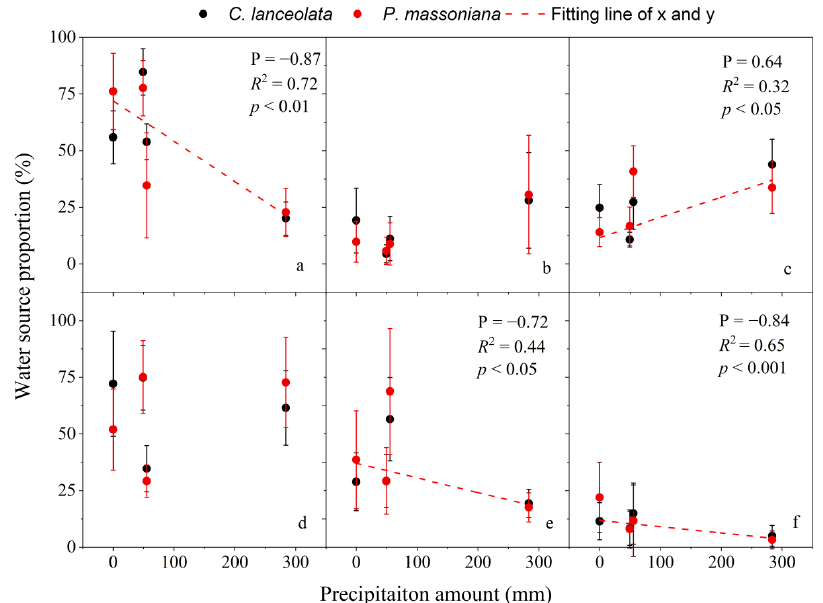
Figure 7. Relationships between water source proportions for each soil layers (mean ± S.D.) and the precipitation amount ten days before sampling. P is Pearson correlation, R 2 represents the fitting degree of the relationship between the water source proportion and the precipitation amount; p is the p -value of the fitting (( a – c ) plant water sources from the shallow, middle, and deep layers in the edaphic habitat, respectively; ( d – f ) plant water sources from the shallow, middle, and deep layers in the rocky habitat, respectively). The black dots represented C. lanceolata , and the red dots represent P. massoniana .